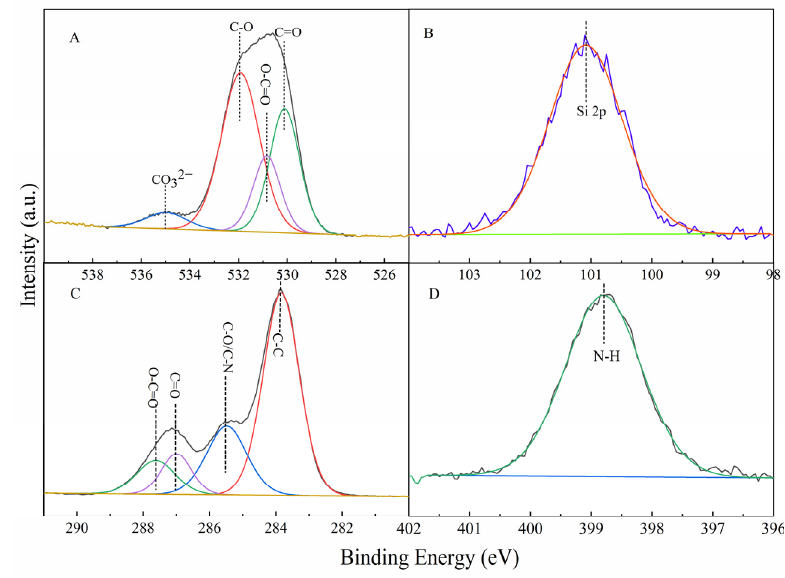
Figure 4. XPS profiles of O 1s ( A ), Si 2p ( B ), C 1s ( C ), and N 1s ( D ) peaks for CAAMC.